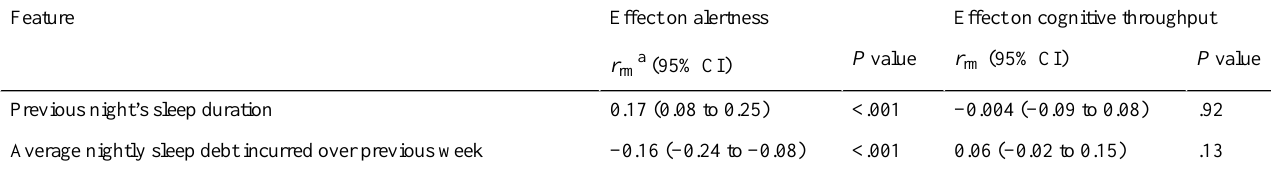
Table 4. Effect of sleep duration on daytime alertness and cognitive throughput.